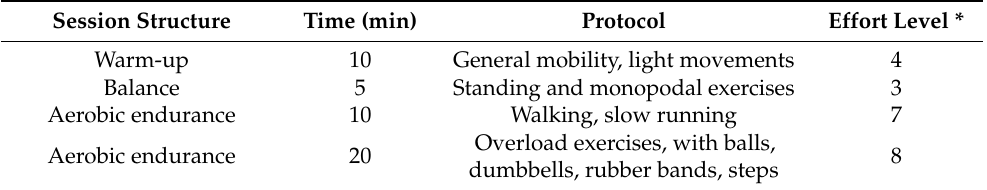
Table 7. Physical activity protocol performed in each training session. Session Structure Time (min) Protocol Effort Level * Warm-up 10 General mobility, light movements 4 Balance 5 Standing and monopodal exercises 3 Aerobic endurance 10 Walking, slow running 7 Overload exercises, with balls, Aerobic endurance 20 dumbbells, rubber bands, steps